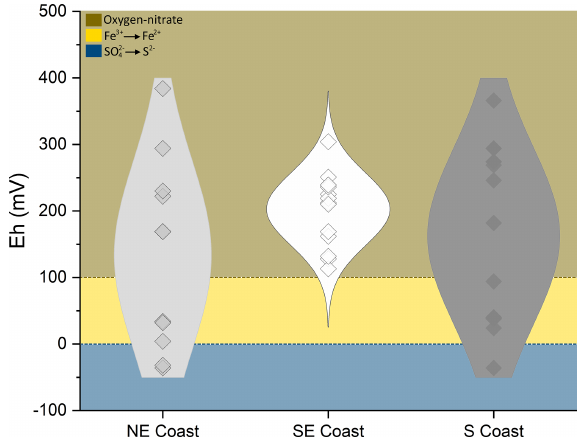
Figure 6. E h values registered in the studied soil profiles. The shaded areas indicate the E h intervals indicative of oxygen, ni- trate ( < + 100mV; brown area), Fe ( + 100–0mV; yellow area), and SO 2 − reductions (blue area) at a pH close to 7.0 (Søndergaard, 4